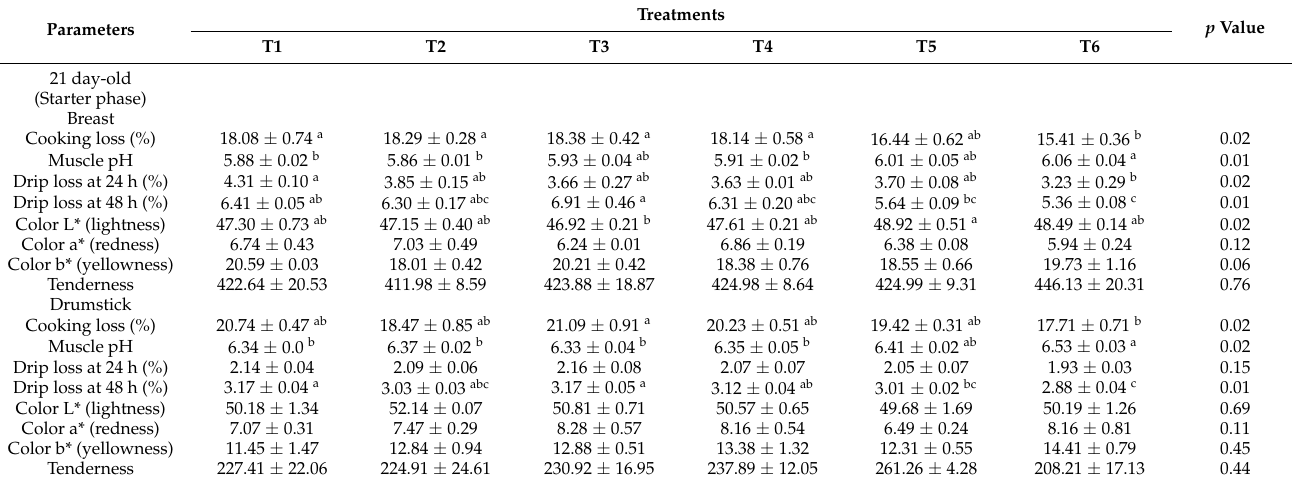
Table 8. Effect of Y. schidigera supplementation on the meat quality of broilers on day 21.